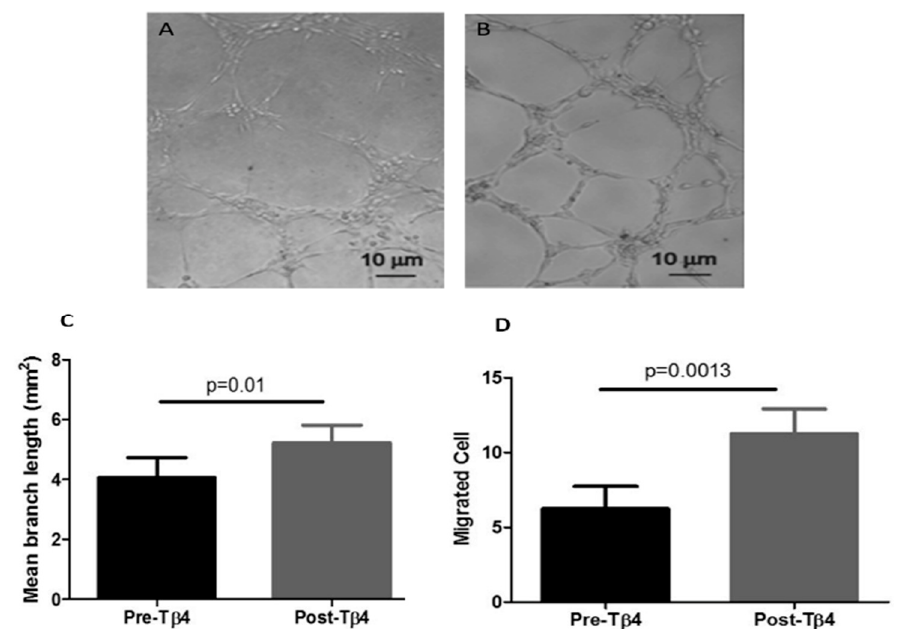
Figure 1. Function of EPCs in vitro. Representative images of tubule formation on Matrigel by non-T β 4 treated ( A ) and T β 4-treated ( B ) EPCs. ( C ) Quantification of mean branch length of tubules. ( D ) Quantification of EPCs in migration assay (Magnification of A&B = 40 × ) ( n = 8). 3.2. T β 4 Treatment Increased the Expression of Angiogenic Growth Factors from EPCs Isolated from ZDF